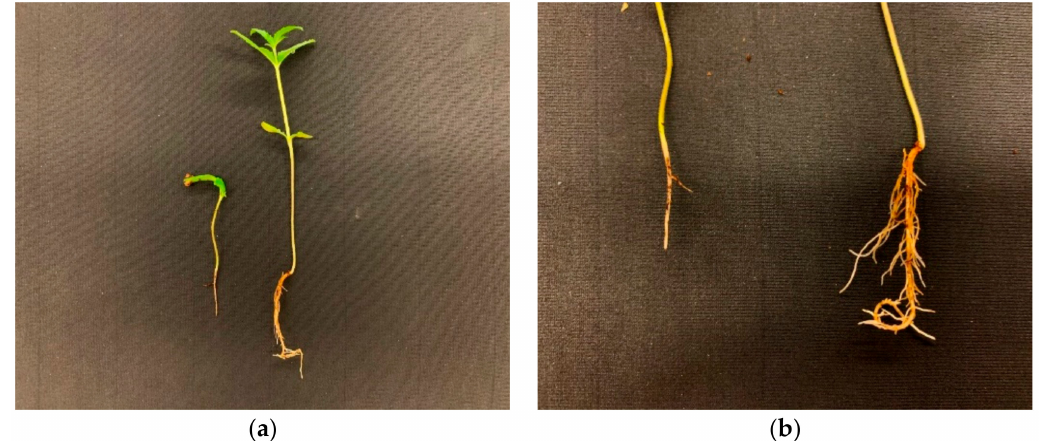
Figure 9. Images of abnormal ‘Picolo’ seedling ( a ) and as compared to a healthy seedling ( b